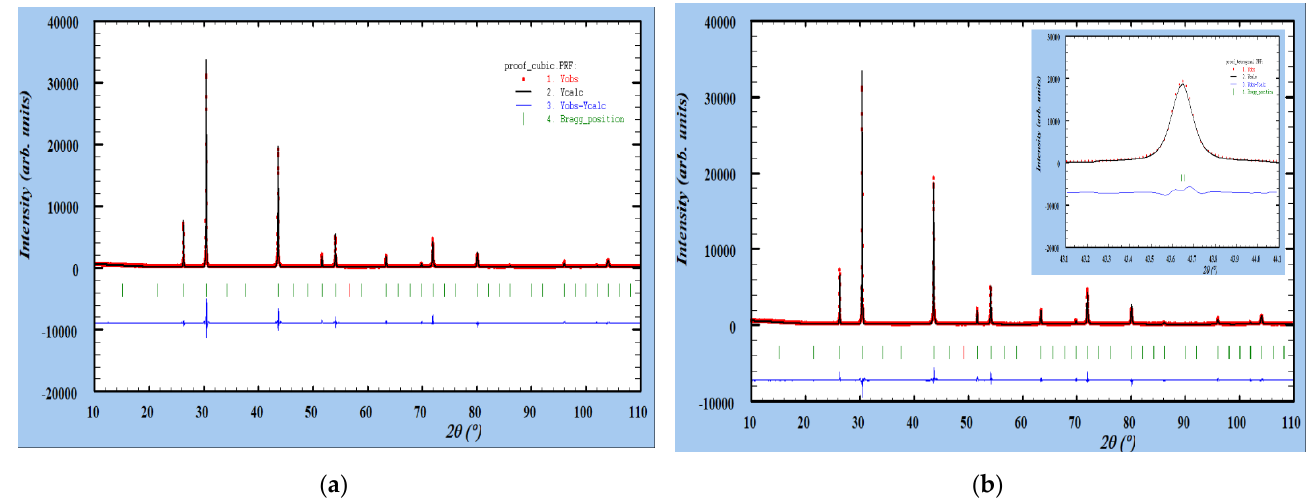
Figure 3. Rietveld refinement of the XRD data obtained for AgSnBiSe 3 (including the profile fit, profile difference, and profile residuals), which was performed with the Fullprof software. ( a ) Cubic Pm-3m and ( b ) tetragonal P4/mmm space groups at RT (the insert shows a selected area). Bragg’s R-factors of the cubic space group were R b = 3.32 and R wp = 4.44. Bragg’s R-factors of the tetragonal space group were R b = 5.72 and R wp = 4.88.